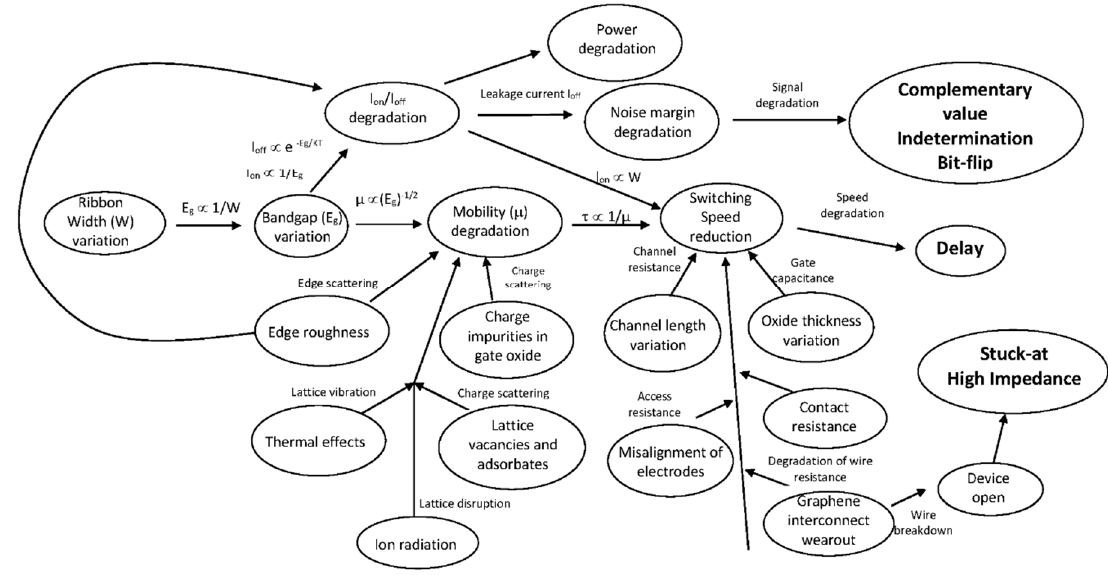
Figure 5. Fault propagation graph for GNR FET logic circuits.